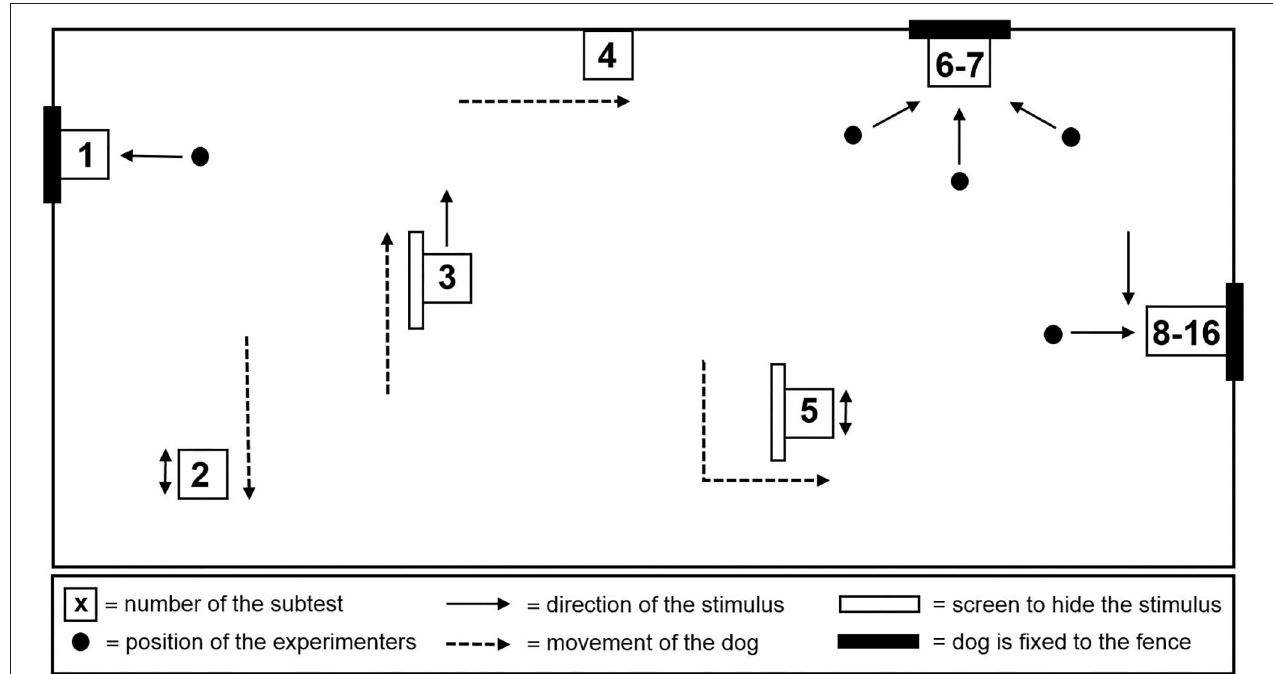
FIGURE 1 | Schematic plan of the test